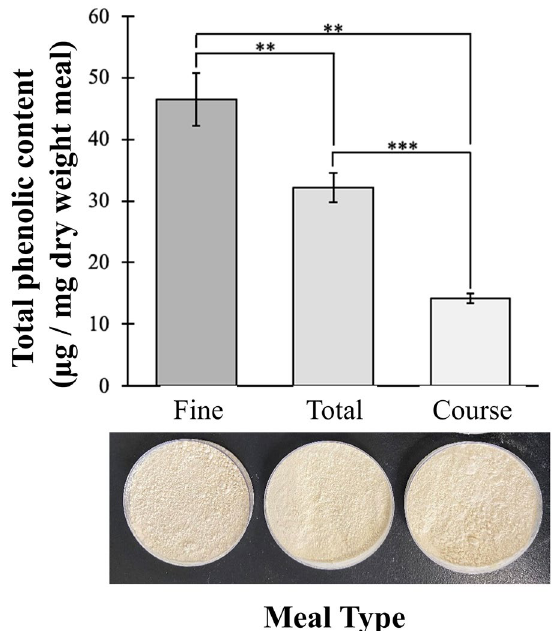
Fig. 3 Total phenolic content of three faba bean meal fractions. Fine, total, and coarse faba bean meal fractions (see representative images) were reacted with the Folin–Ciocalteu reagent for 45 min. The absorbance at 725 nm was obtained and compared to a calibration curve for tannic acid (Additional file 1: Figure S2). Total phenolic content is represented as µg of phenolics per mg (dry weight) meal. Data are presented as the mean and standard deviation of the